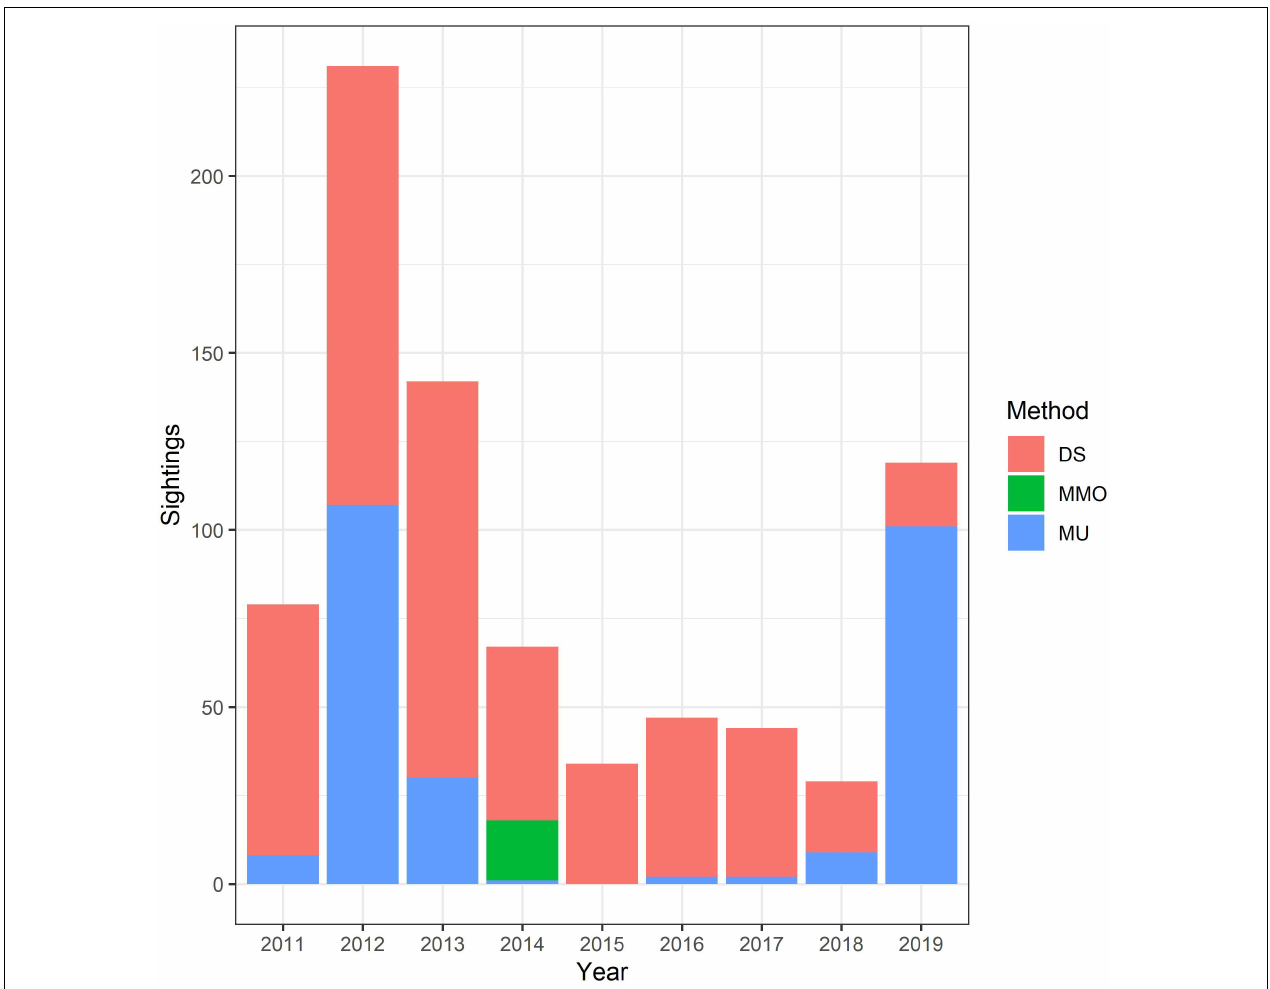
FIGURE 4 | Number of reports per data collection method and year between 2011 and 2019. Data collection methods: marine users (MU), dedicated surveys (DS) and marine mammal observers